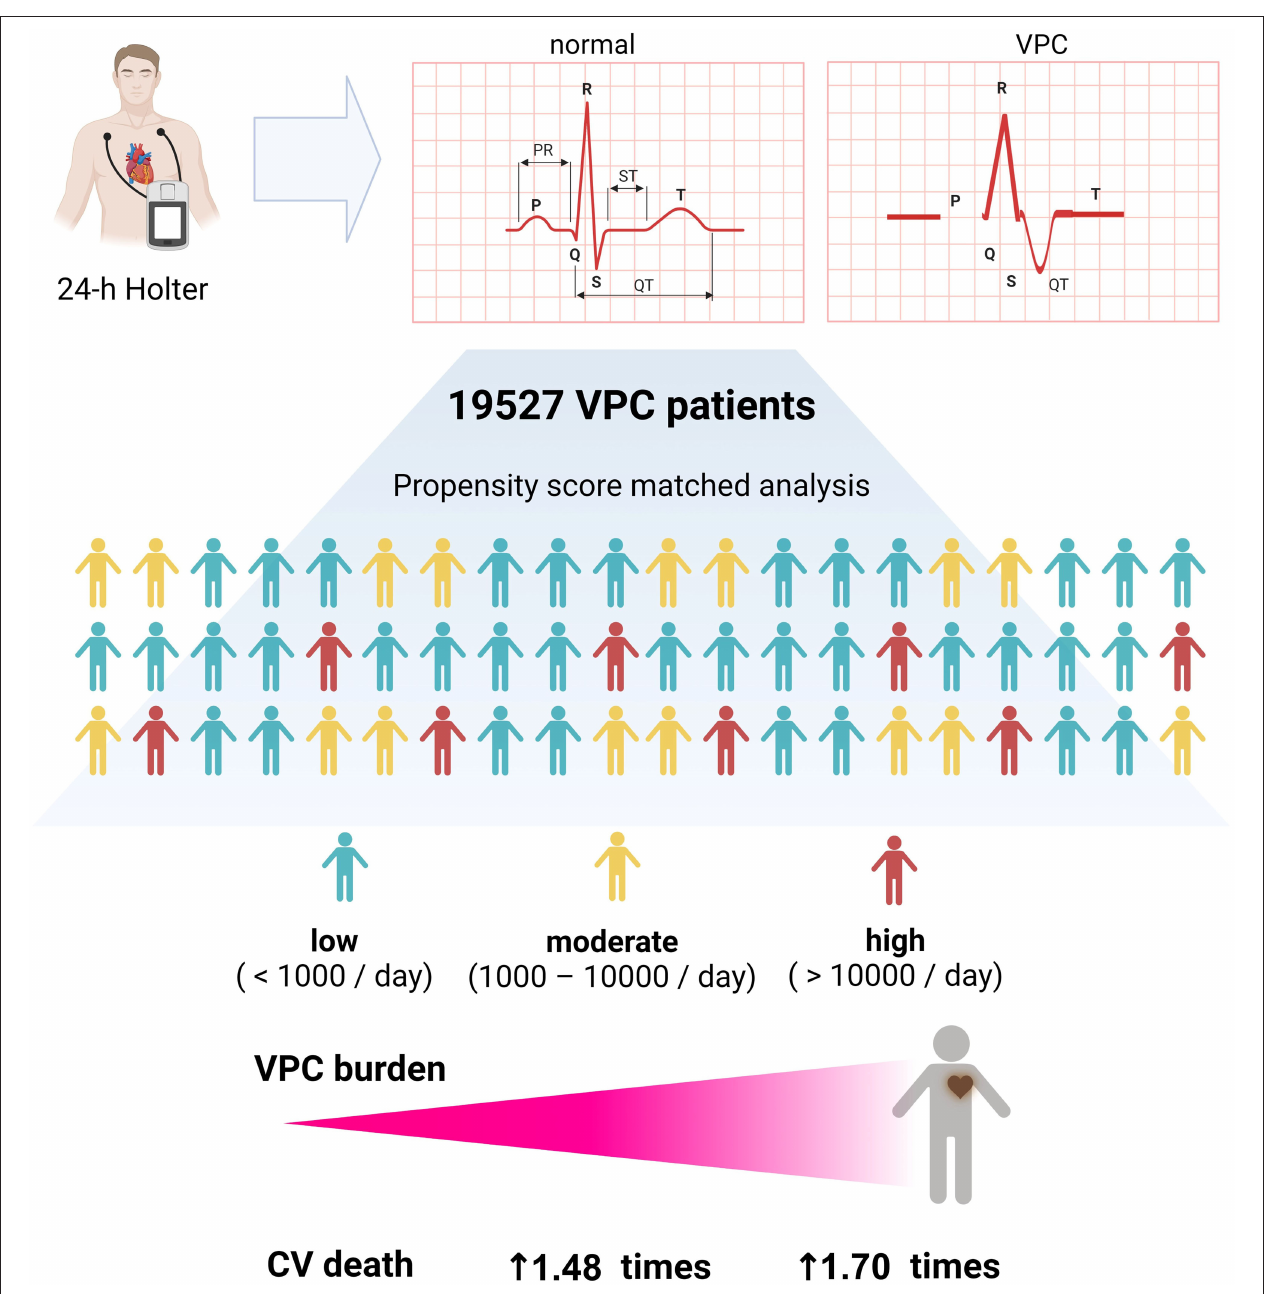
FIGURE 5 | Graphic abstract of this study. A high and moderate VPC burden led to more cardiovascular death, and a high VPC burden had 1.70 times of cardiovascular death risk.